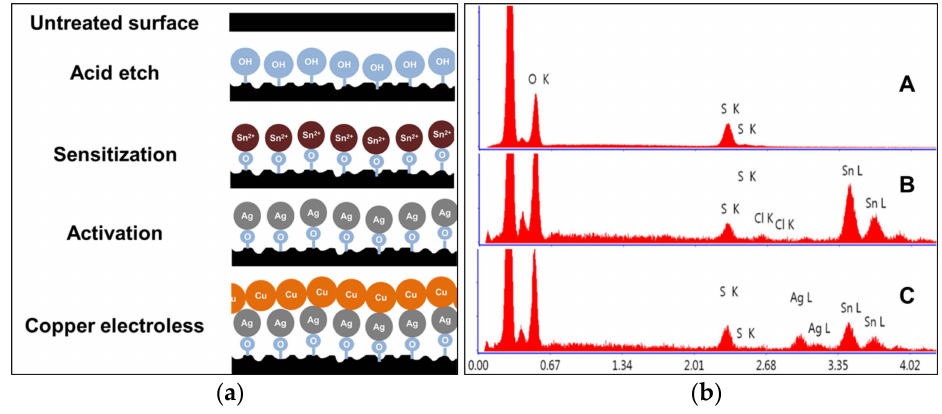
Figure 2. ( a ) Illustration of the proposed evolution of the species at the surface. ( b ) EDS spectra of the Figure 3: surface after pre-treatment stages: (A) chemical etch, (B) sensitization, and (C)